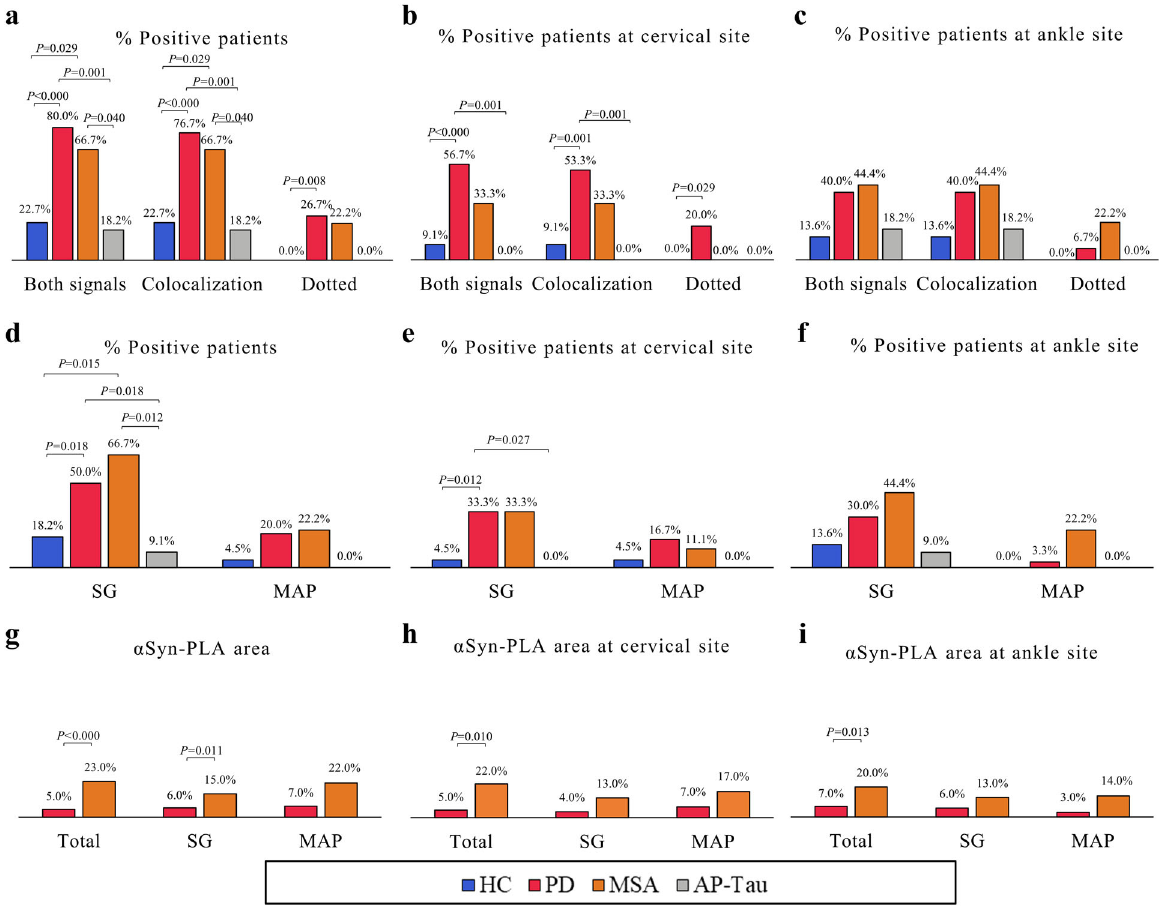
Fig. 3 α Syn-PLA signal is signi fi cantly more expressed in PD and MSA. a – c α Syn-PLA signal is higher in PD and MSA. d – f The signal is observed mainly in the autonomic fi bers surrounding SG and to a lesser extent MAP independently from the anatomical site. g – i The area of